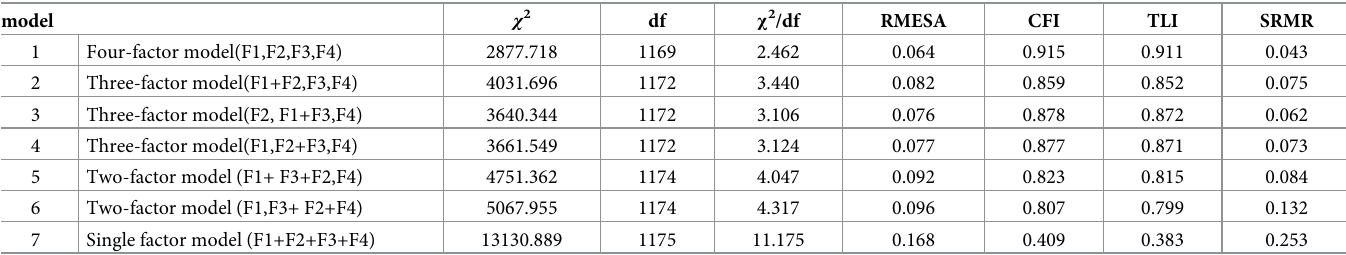
Table 1. Comparison of confirmatory factor analysis.